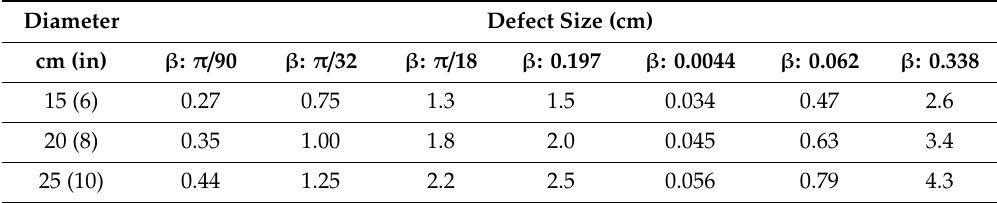
Table 5. Relationships between β (defect size) in radians and cm for di ff erent pipe sizes. Diameter